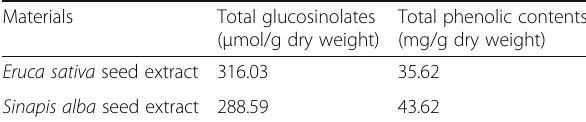
Table 6 Total glucosinolates ( μ mol/g dry weight) and total phenolic contents (mg/g dry weight) in the seed powder of both Eruca sativa and Sinapis alba